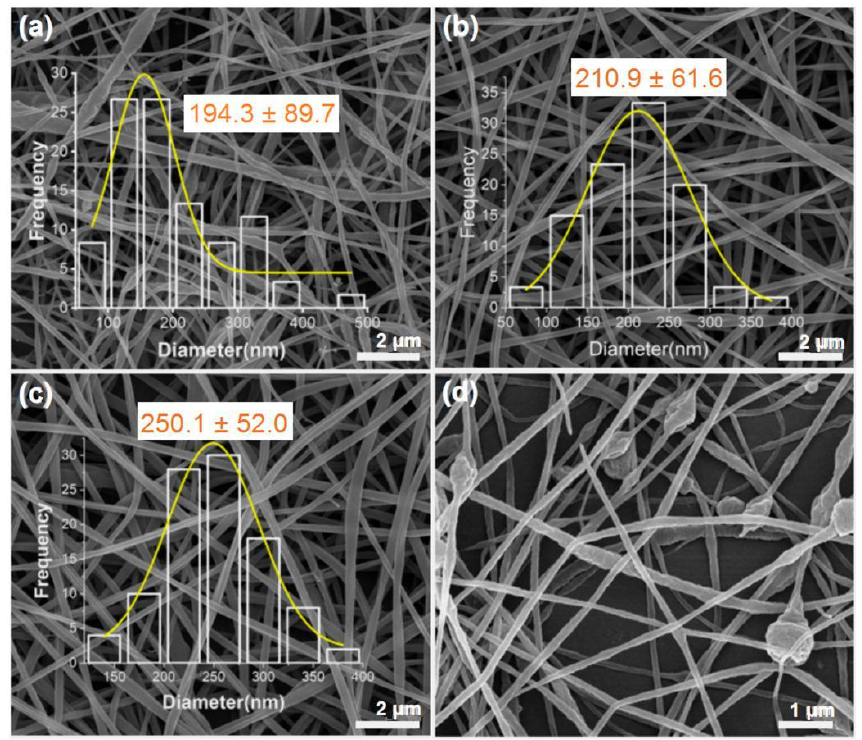
Figure 3. SEM images of zein fibers with different ferulic acid loadings: ( a ) 0% FA; ( b ) 10% FA; ( c ) 15% FA; ( d ) 20% FA.